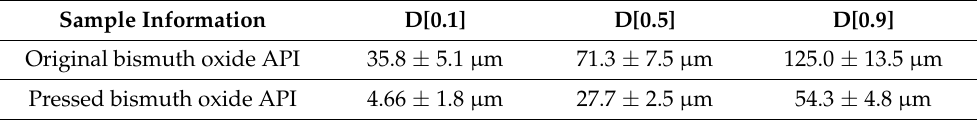
Table 4. PSD values (with laser diffraction) of bismuth oxide API before and after pressure at 10 tons.